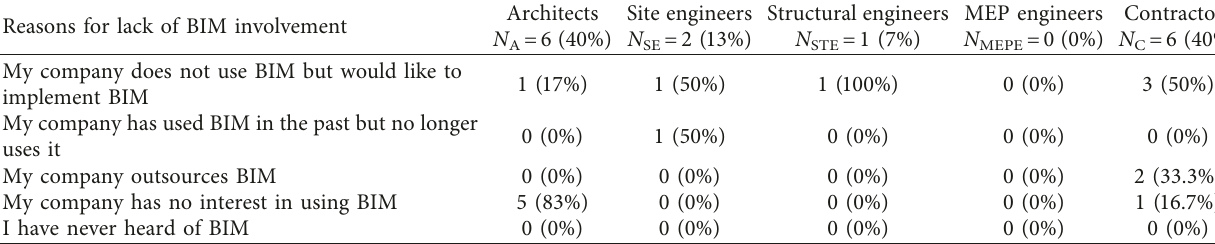
Table 5: Relationship between role of the respondent and the reason for their company’s lack of BIM involvement. Reasons for lack of BIM involvement